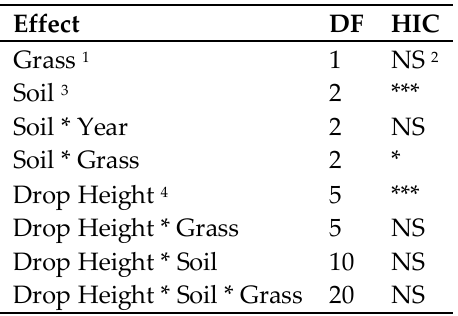
Table 1. Analysis of covariance described the effects of year, grass species, soil type, and drop height on head injury criterion (HIC) in Knoxville, TN, USA in 2016 and